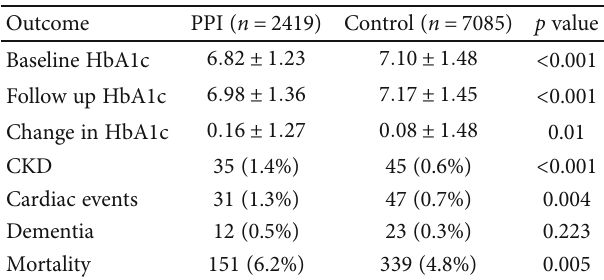
Figure 2: Trends of the changes in HbA1c values plotted across the time exposed to proton pump inhibitor treatment (in years). Table 3: Clinical outcomes of the study